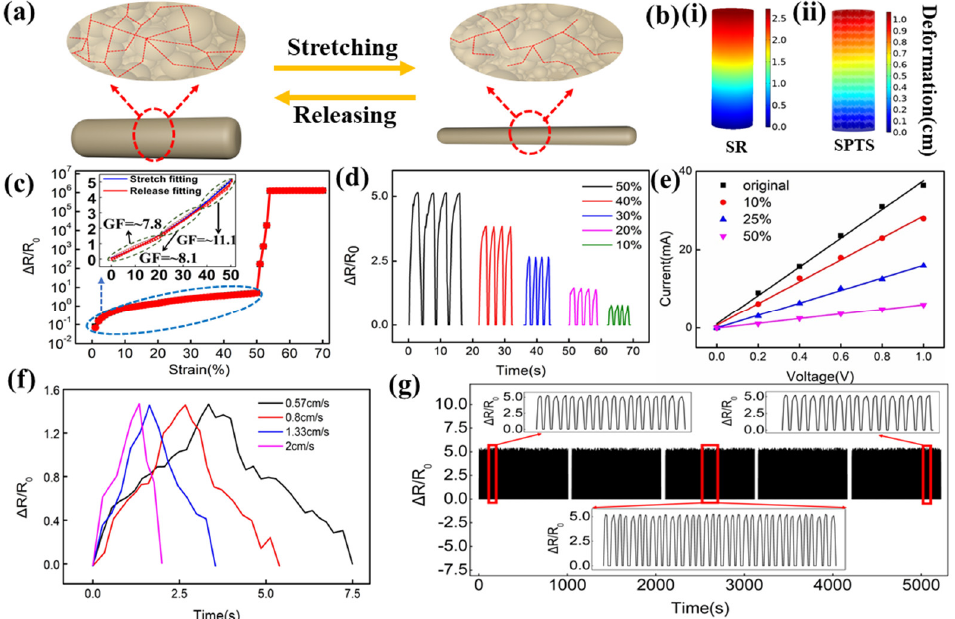
Figure 2. ( a ) The tensile-resistance sensing mechanism of the SPTS. ( b ) The strain distributions for the SR and SPTS being stretched force. ( c ) Curves of relative change in resistance against the different stretched and released strains. ( d ) Responsive behaviors of the SPST at different stretching amounts. ( e ) The current-voltage curves of the SPTS for tensile strain in the range of 0–50%. ( f ) The correlation between the relative variation in resistance versus tensile speeds. ( g ) Stability test during 1000 cycles at operating strain of 50%.